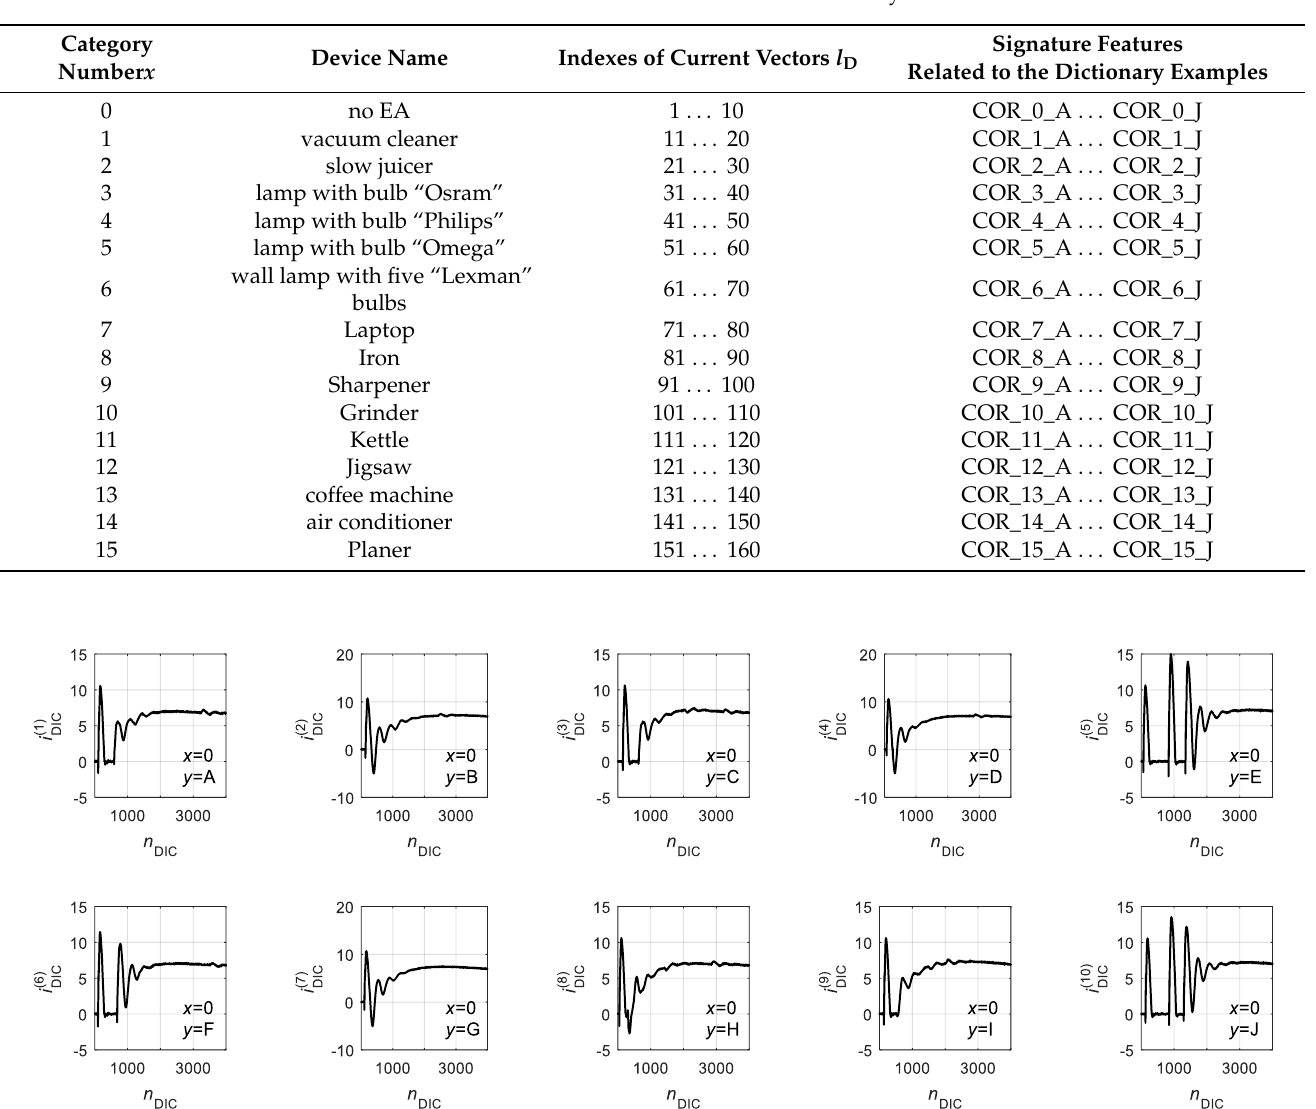
Table 3. Information about the transient dictionary.